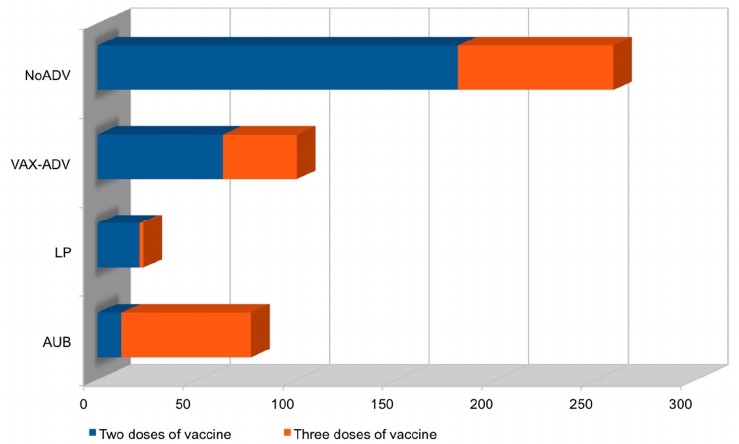
Figure 2. Histogram of COVID-19 vaccines doses and corresponding adverse effects. Legend and abbreviations: y = vaccinated women with menstrual irregularities due to other causes, NoADV/vaccinated women whose menstrual irregularities could be adverse effects to vaccine, VAX-ADV/which adverse effect, late period, LP, or abnormal uterine bleeding, AUB; x = number of all vaccinated women with menstrual irregularities).